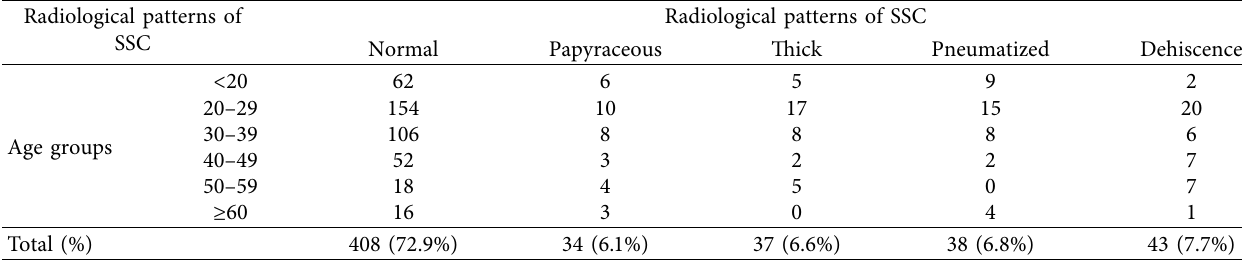
Table 2: Distribution of SSC radiological patterns among age groups.